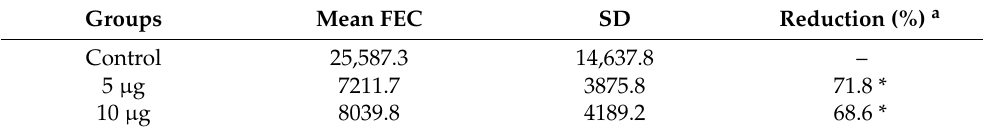
Table 1. Fecal egg count (FEC) from challenged goats in the trials. Fecal samples were collected from individual goats at 14 time points (see Figure 1), and the numbers of Haemonchus contortus eggs per gram were counted. Mean cumulative FEC (with standard deviations, SD) of individual groups was calculated.